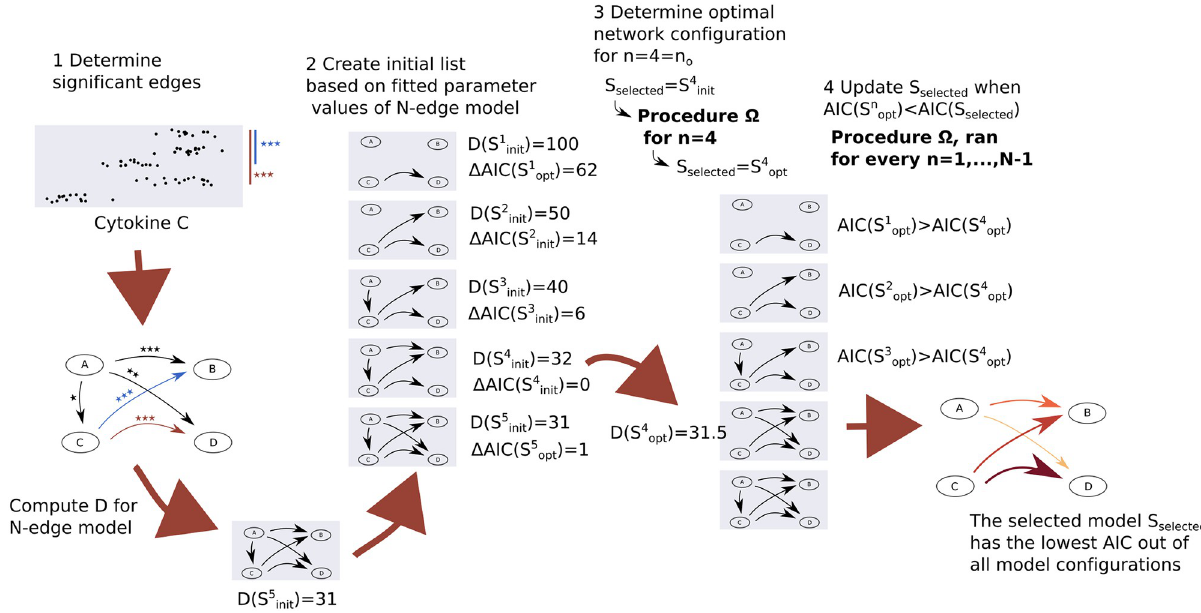
Fig 4. Overview of the key steps of our method. Our method requires log-normally distributed interventional cytokine secretion data that can be used to determine the value of D ¼ (cid:0) 2 log ð L Þ , with the likelihood L defined in Eq (3)), for each network configuration of interest. When the measurement data is not log-normally distributed, a donor-dependent scaling might in some cases be used to render the dataset to be log-normal (e.g. see Section “Application to a dataset on IL23 regulation”). We first (Step 1) perform a statistical analysis on the data to obtain a set of N statistically significant edges for each network size n 2 {1, 2, ... , N }. We fit the (2-sample t-test, p � 0.05, fdr corrected). We then (Step 2) compute a list of initial configurations S n init consists of the n edges corresponding to the n largest fitted edge parameter values of the N -sized model. We N -edge network to the data and let S n init Þ for each n 2 {1, 2, ... , N }. We define S selected as the model configuration with the smallest AIC value currently identified. At the start of compute D ð S n init Step 3, we have S ¼ S n o , with n ¼ argmin ½ AIC ð S n Þ� . To identify the optimal n -sized model configuration S n o , we run Procedure O for models o opt init selected o init n of size n , with output S ¼ S n o (Step 3). We run Procedure O for models of size n = 1, 2, ... , N − 1. Procedure O sets S ¼ S n when o opt selected selected opt Þ � AIC ð S Þ . After N runs of Procedure O , we have that S has the smallest AIC of all possible subconfigurations of the set of AIC ð S n selected selected opt statistically significant edges and corresponds to the model that best balances model complexity and